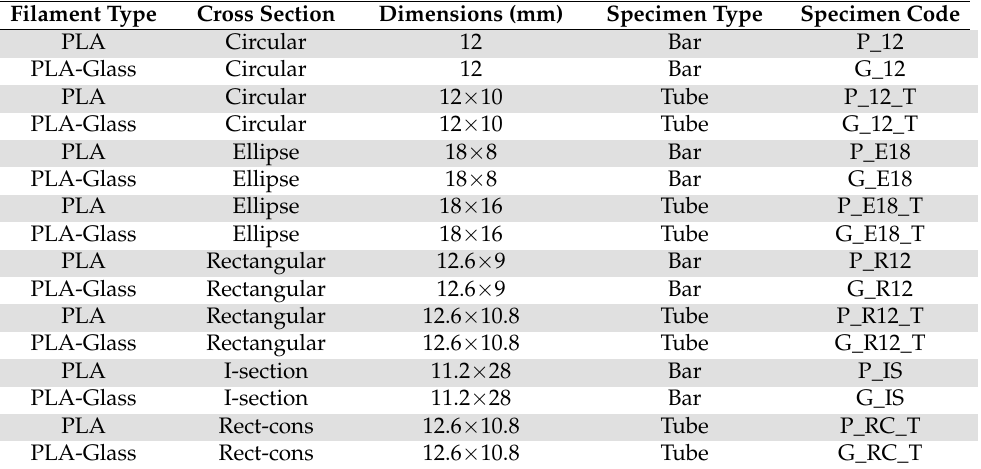
Table 1. Specimen characteristics and codification (coding).